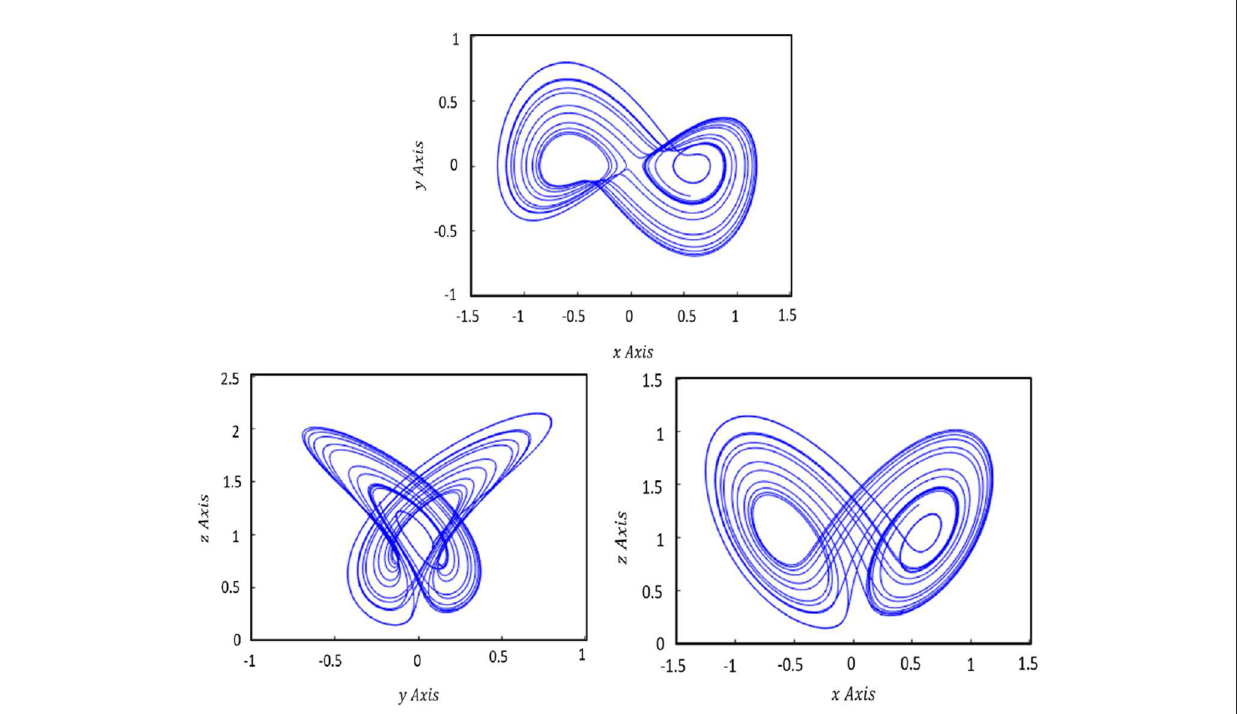
FIGURE2 The chaotic attractor of the Shimizu–Morioka dynamical system on the x Drive